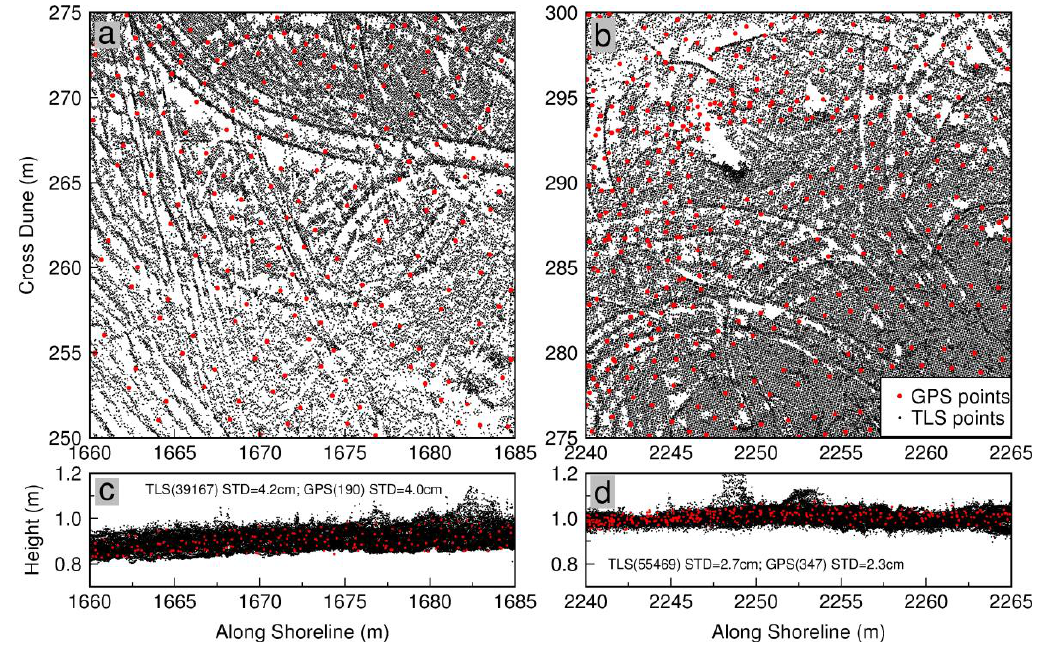
Figure 11. Comparisons of elevations (NAVD88) derived from georeferenced TLS points and kinematic GPS points. TLS datasets are collected with the rapid surveying method. ( a ) and ( b ): Locations of TLS and GPS surveying points within two 5 m by 5 m areas A and B, as marked in Figure 9; ( c ) and ( d ): elevation measurements from all TLS and GPS survey points in areas A and B, respectively.